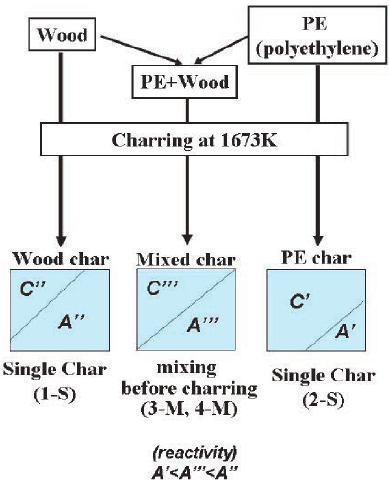
Fig. 1: Difference of nature of char with Charring condition A: amorphous carbon, C: crystallized carbon.